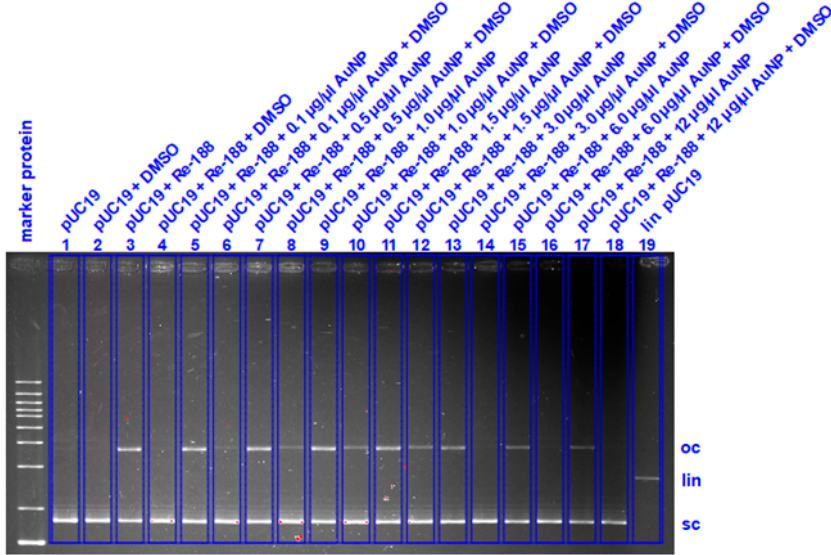
Figure A18. Evaluation of the irradiation experiments using Re-188 in combination with AuNPs 1 via gel electrophoresis. Left line is the marker protein. The lowest bands show intact sc-DNA, middle bands show lin-DNA with DSBs, and the highest band show oc-DNA with SSBs. The direction of elution is from top to bottom.